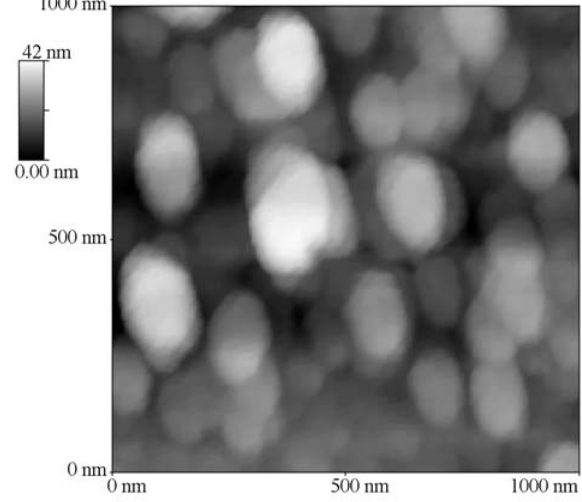
Figure 5. AFM image of the top surface of the PSf modified by argon plasma, 5 W, 40 min. R a = 2.0 nm.